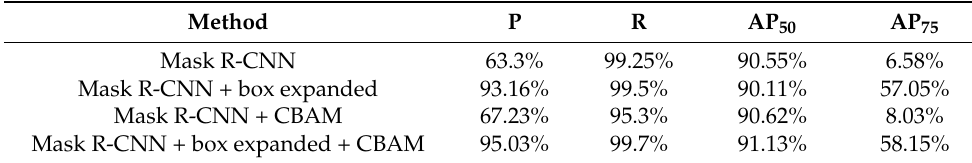
Table 1. Comparison of segmentation effect.